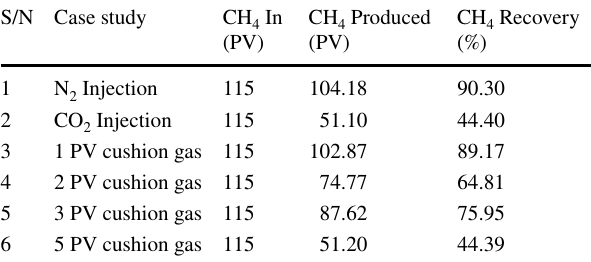
Table 4 CO 2 produced and stored during EGR for all the